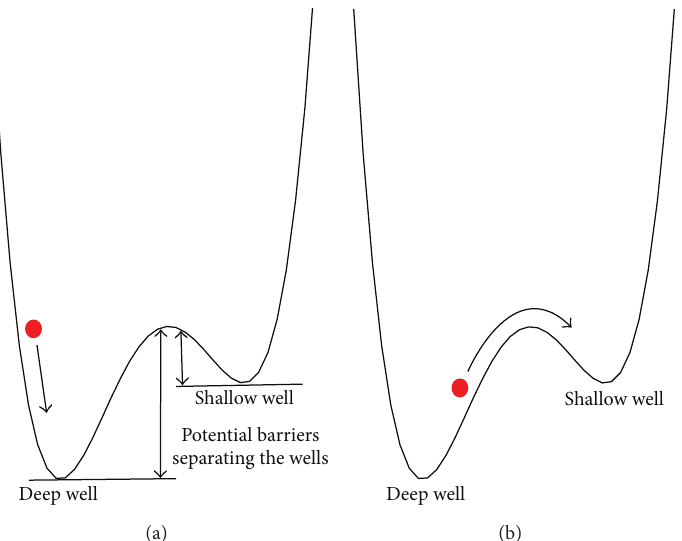
Figure 1: Schematic picture of a particle in a double-well energy potential. (a) The unperturbed particle falls into one of the two wells from its initial position (deterministic case). (b) The particle subjected to a random perturbation jumps from a well to the other randomly (stochastic